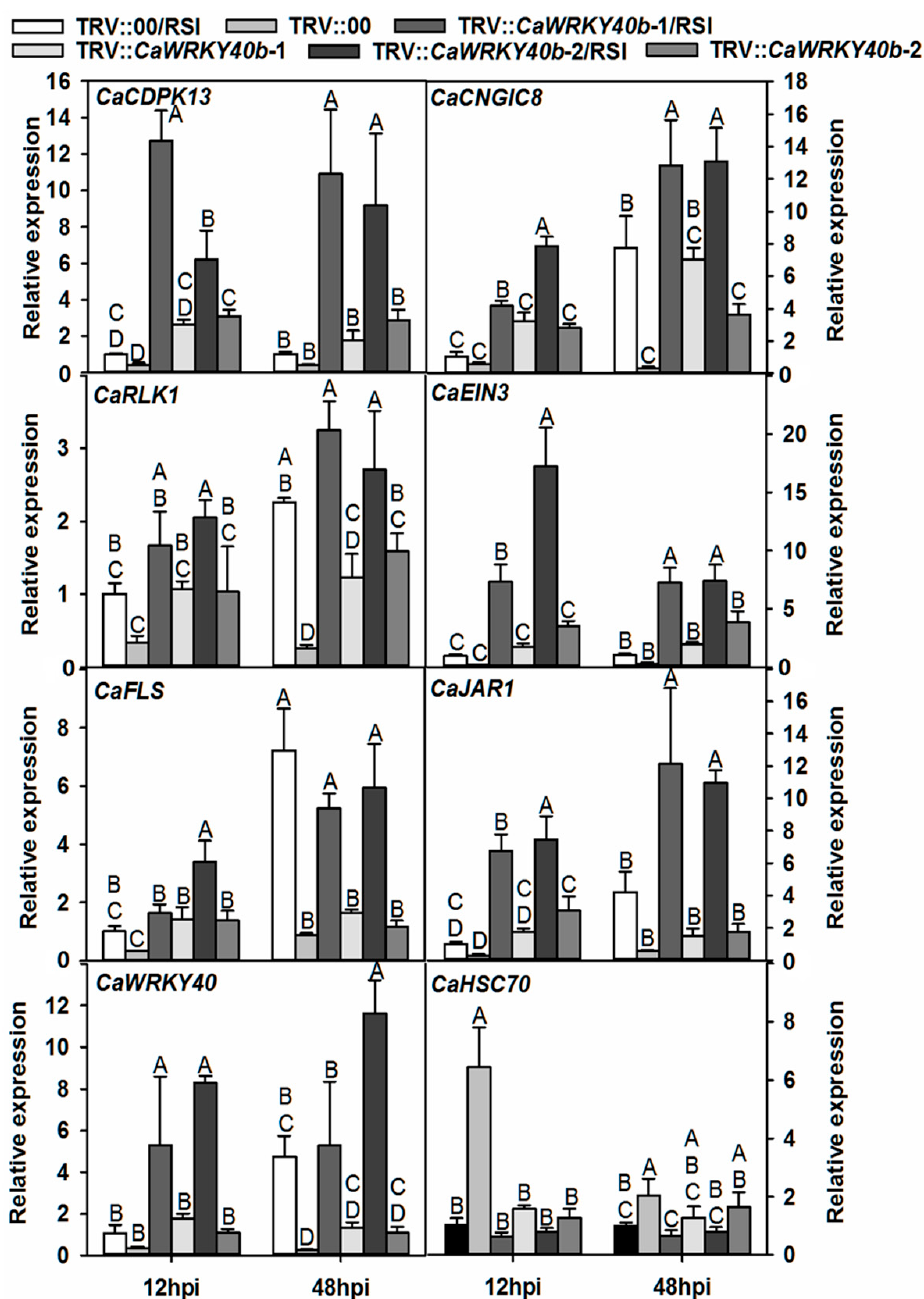
Figure 5. q RT-PCR analyses of transcriptional levels of the tested defense-related genes in the leaves of pepper plants. The CaWRKY40b -silenced and the control pepper plants were inoculated with 1.0 mL of 108 cfu · mL − 1 (OD600 = 0.8) virulent R. solanacearum strain FJC100301 by root irrigation. Data represent the means ± SD of four independent biological replicates, each containing three plants. Different capital letters indicate significant differences, as determined by Fisher’s protected LSD test: uppercase letters, p < 0.01; lower case letters, p < 0.05.